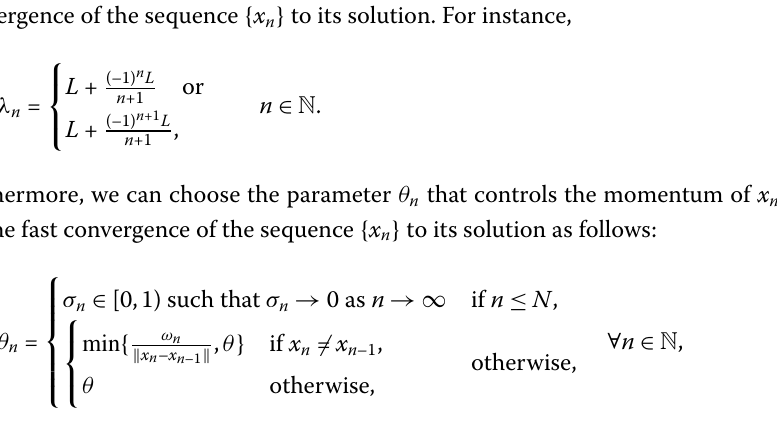
convergence of the sequence { x n } to its solution. For